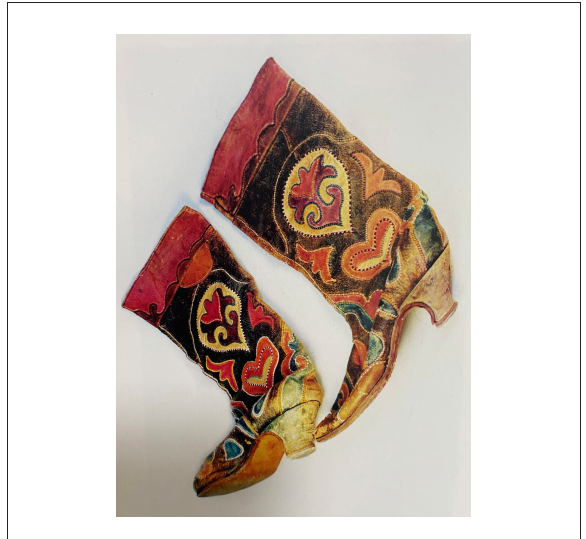
FIGURE12 Boots in Kazakh. Figure 12 is from Xu (2015); Figure 13 is from National Museum of Korea (2018).